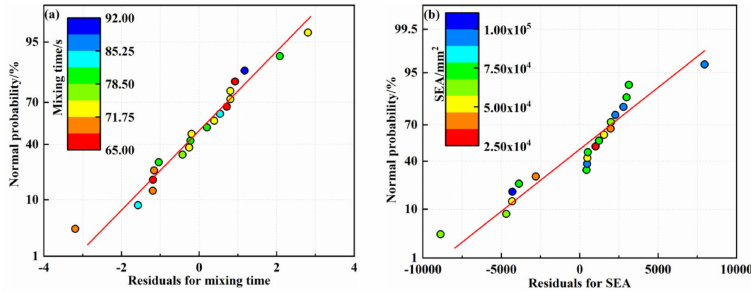
Figure 7. Normal probability distributions of residuals for ( a ) MT and ( b ) SEA